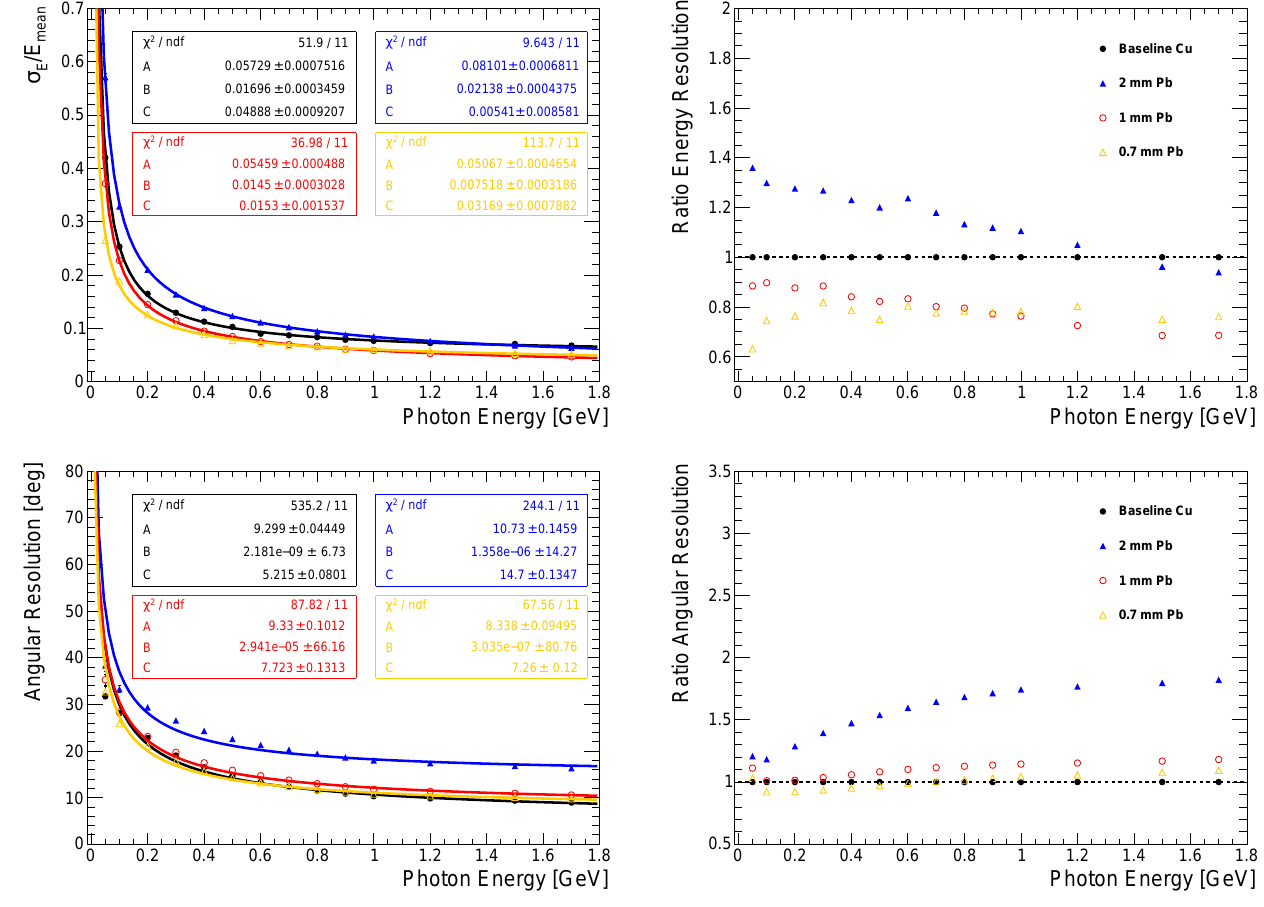
Figure 77. Energy and angular resolution and ratio for different ECAL detector absorber